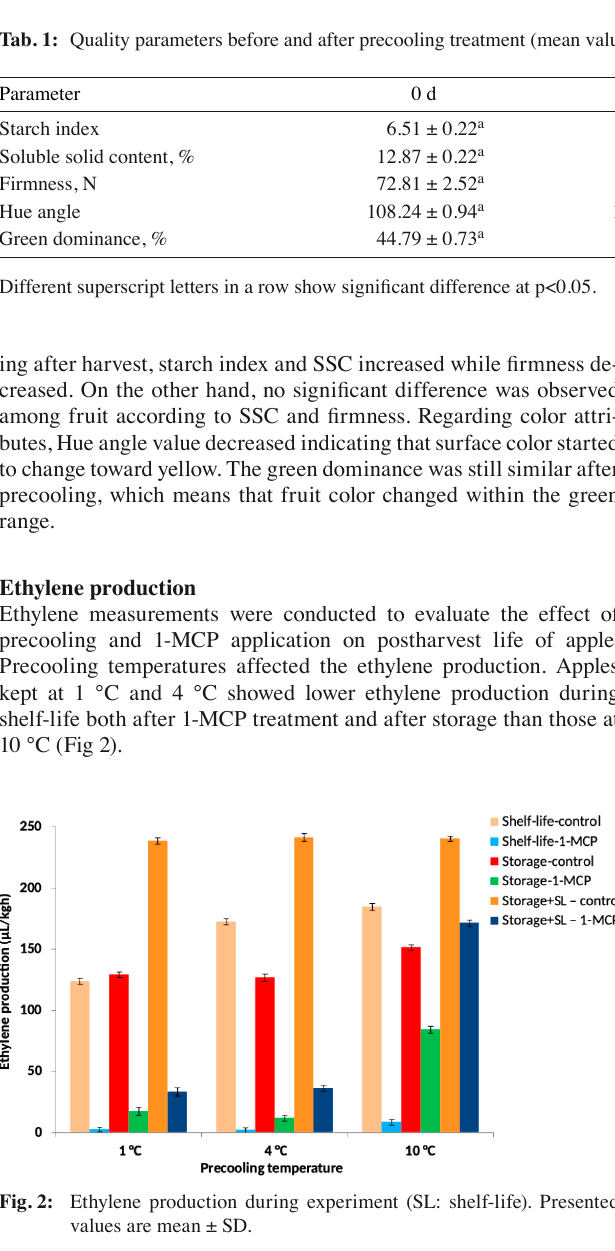
The 1-MCP inhibited strongly the ethylene production. After 6 months of storage and during the following shelf-life, treated samples showed lower values than control but at different rate. Fruit of 1 °C and 4 °C precooling treated with 1-MCP had lower level in ethylene